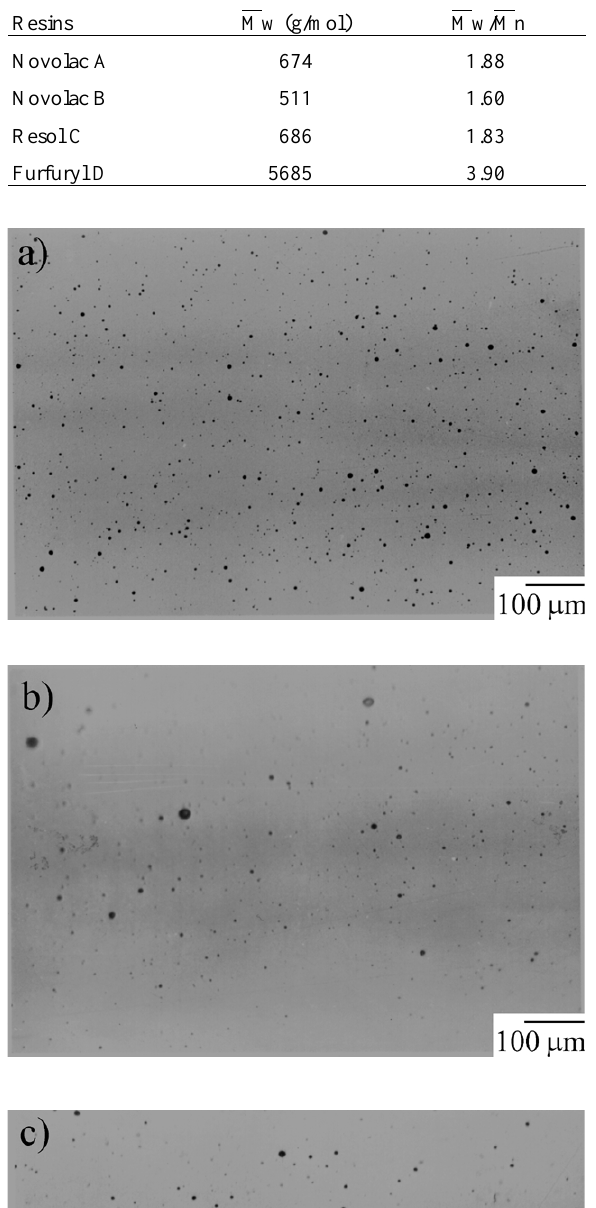
Table 2. SEC results for the phenolic and furfuryl resins. Resins